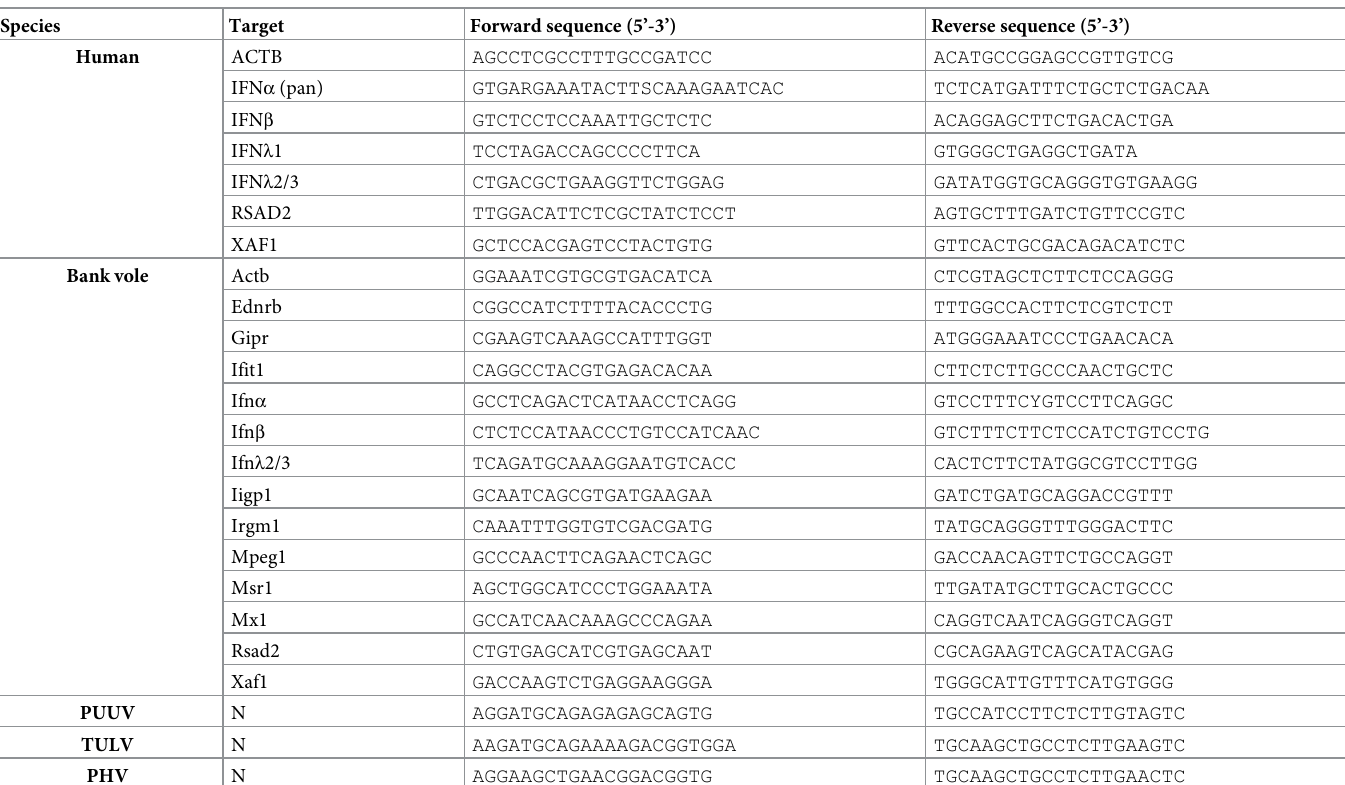
Table 1. Sequences of the primers used for RT-qPCR.